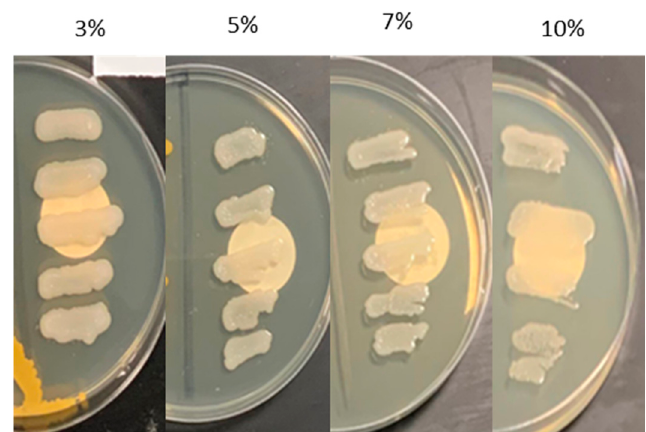
Figure 1. DPM17 growth under different NaCl concentrations.